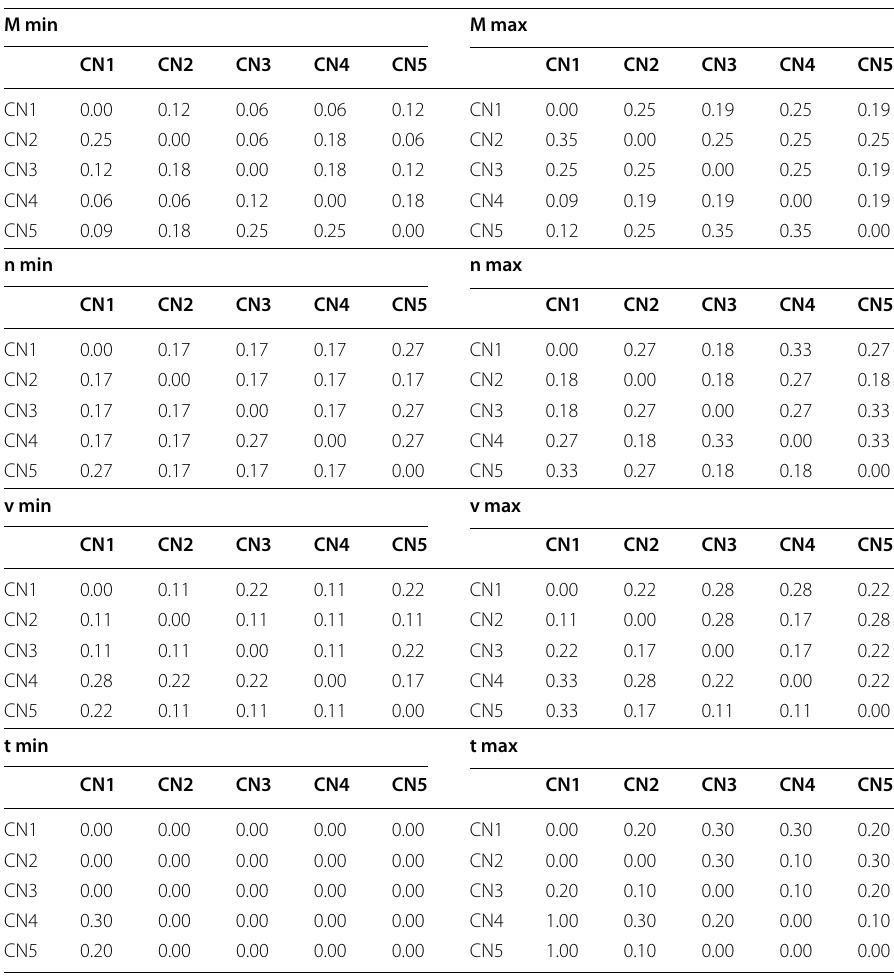
Table 17 Normalized element matrixes of picture fuzzy rough sets